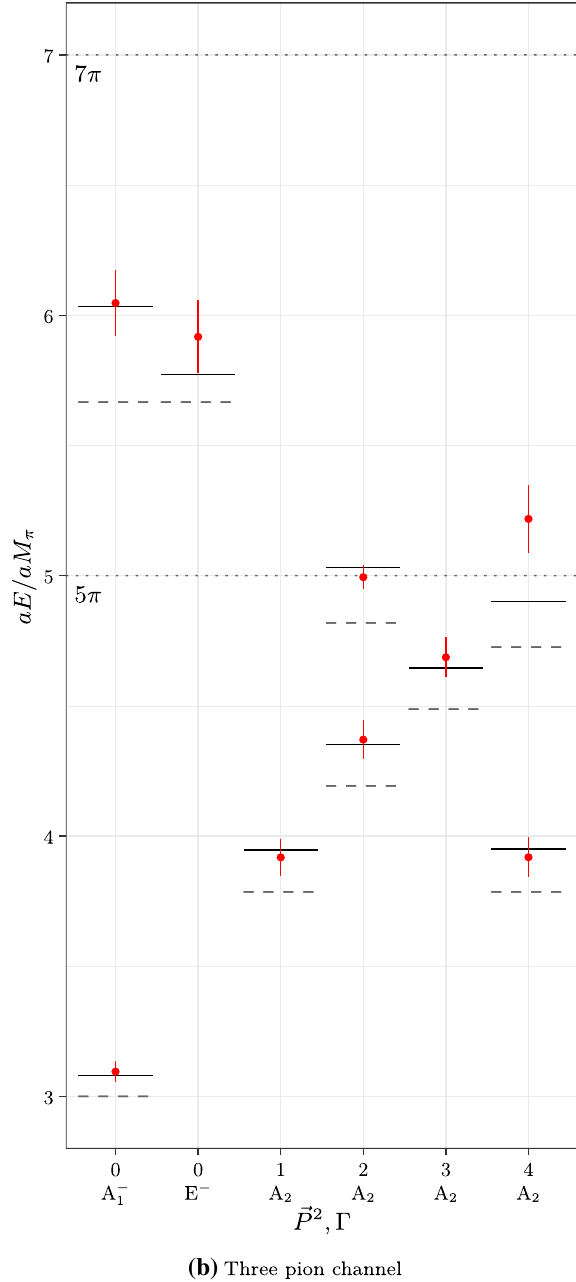
Fig. 11 The center-of-mass spectrum for two and three pions on the physical point ensemble (cA2.09.48). The red data points are the energy levels determined from the correlator. The black lines denote the pre- diction from the quantization condition. For the two-pion A 1 levels, and all three-pion levels, we use the fit in Table 6 in the main text. For the